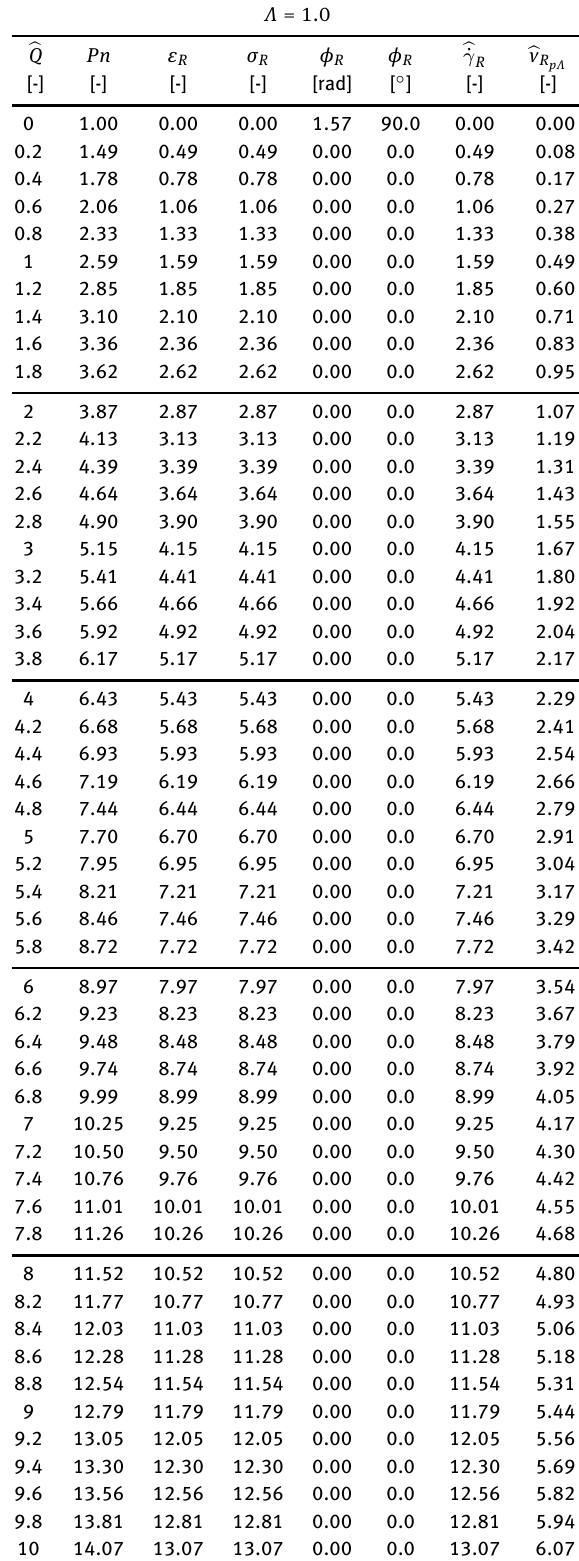
Table E3: Brief summary of numerical values of the discharge rela- tions shown in Figure 7 for a thixotropy factor Λ = 1.0